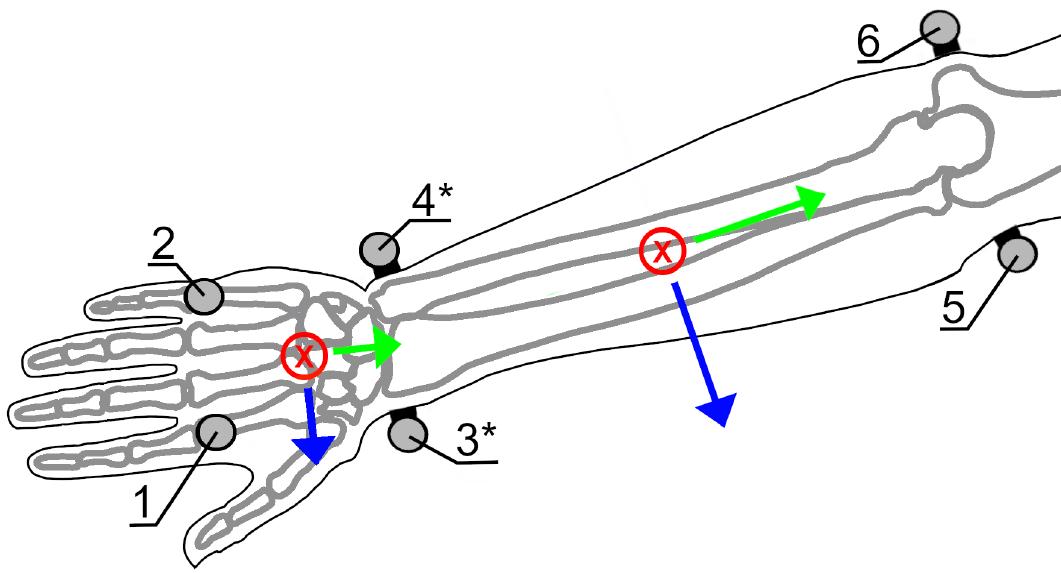
Figure 3. Forearm and hand coordinate systems and markerset, showing corresponding anatomical landmarks including: Second metacarpal-phalangeal joint ( 1 ), fifth metacarpal-phalangeal joint ( 2 ), radial styloid process ( 3 ), ulnar styloid process ( 4 ), medial humeral epicondyle ( 5 ), and lateral humeral epicondyle ( 6 ). * Markers 3 and 4 are placed on the wearable